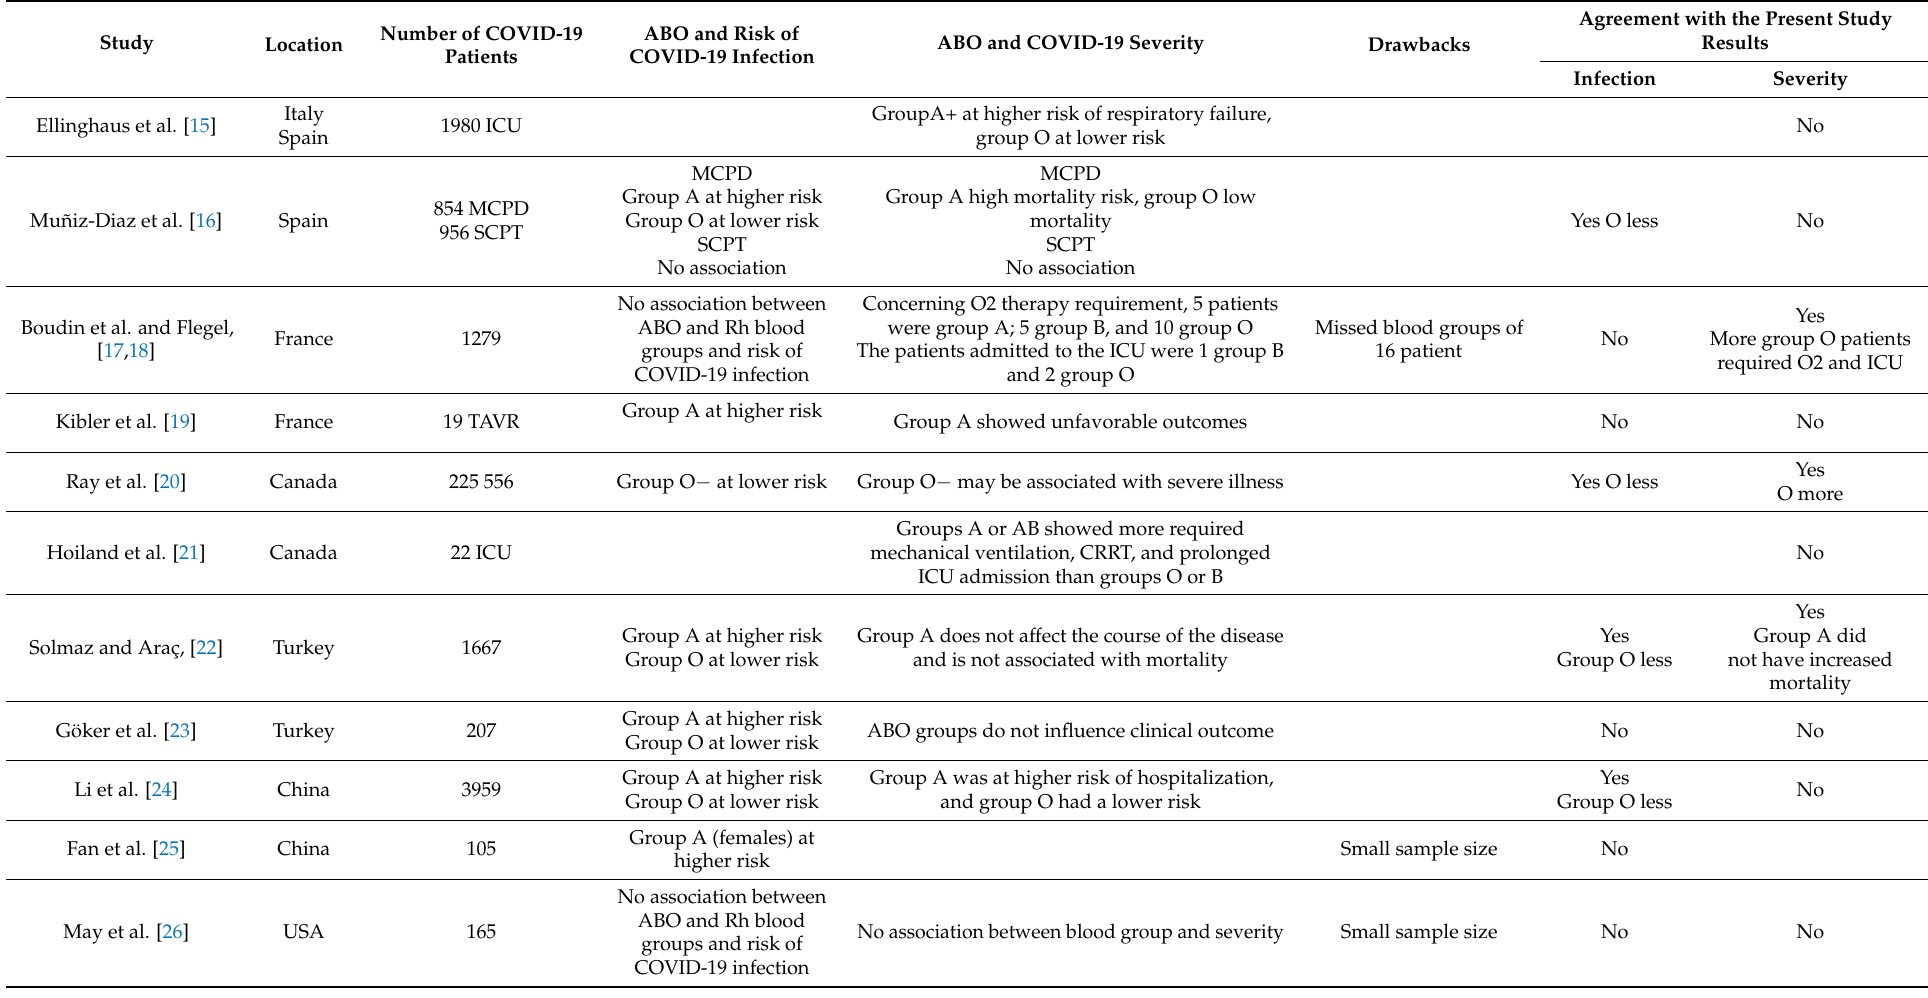
Table 3. Outcomes of some research studies which document the effect of ABO blood grouping on the risk of COVID-19 infection and severity and its comparison with the present study